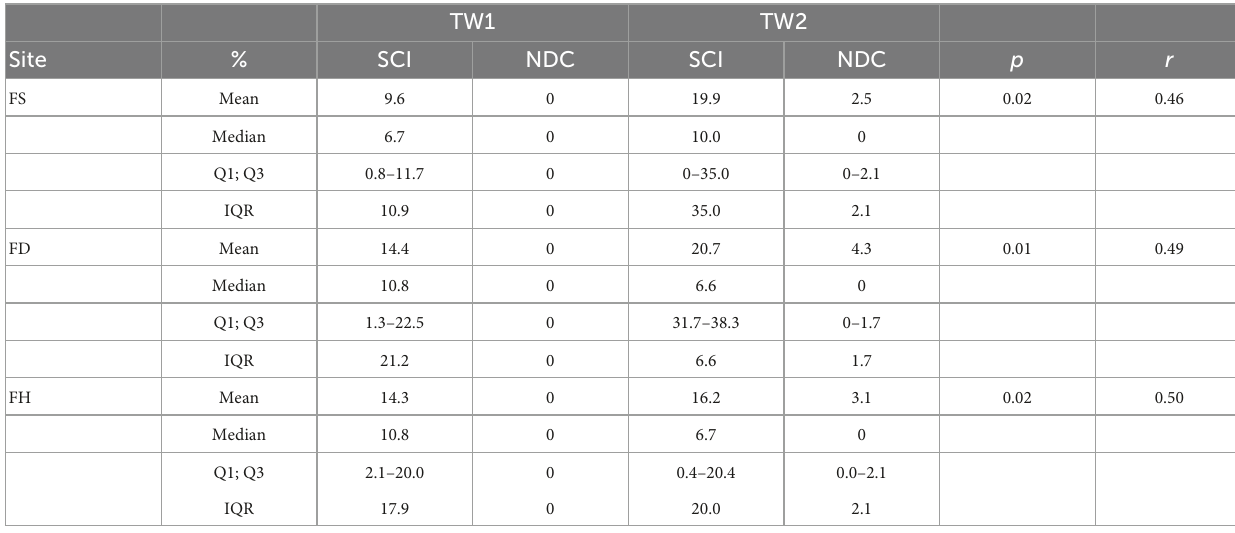
TABLE 2 Response rate (%) of SCI-patients and NDC’s to 60 laser stimuli. TW1